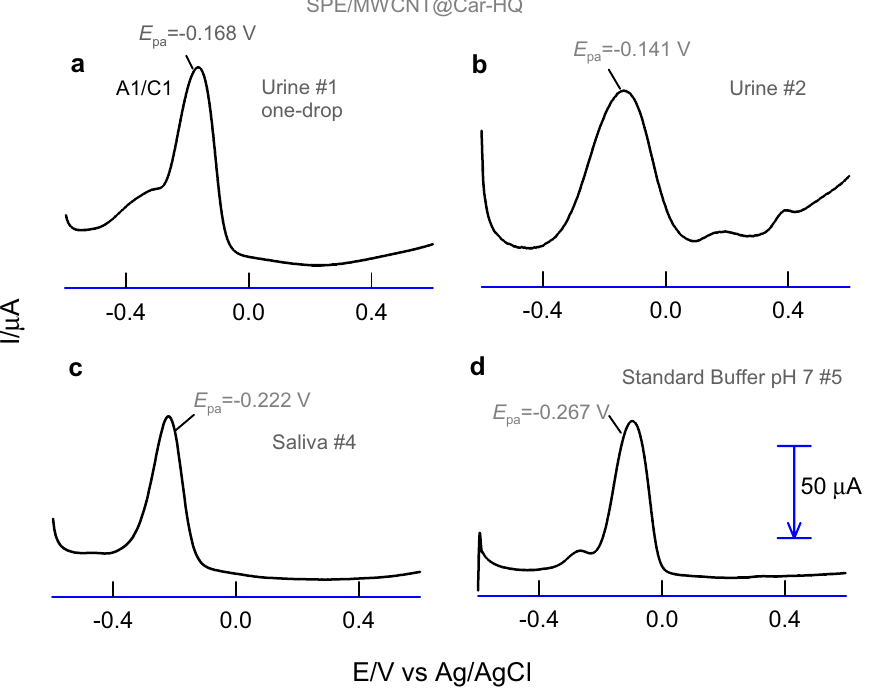
Figure 8. DPV responses of SPE/MWCNT@Car-HQ modified with one-drop (3 µL) of various real samples ( a – d ). #1–#2 = different human urine samples, c saliva and d standard pH 7 buffer.